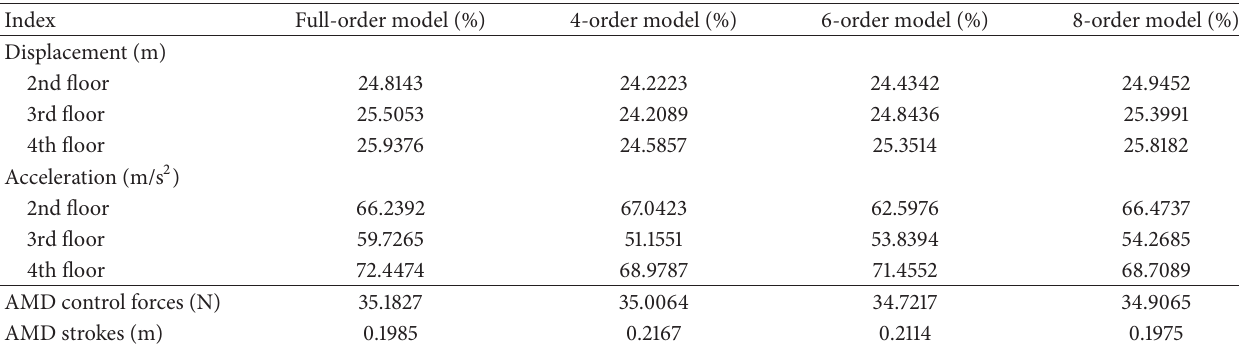
Table 6: Comparison of control effects of different control